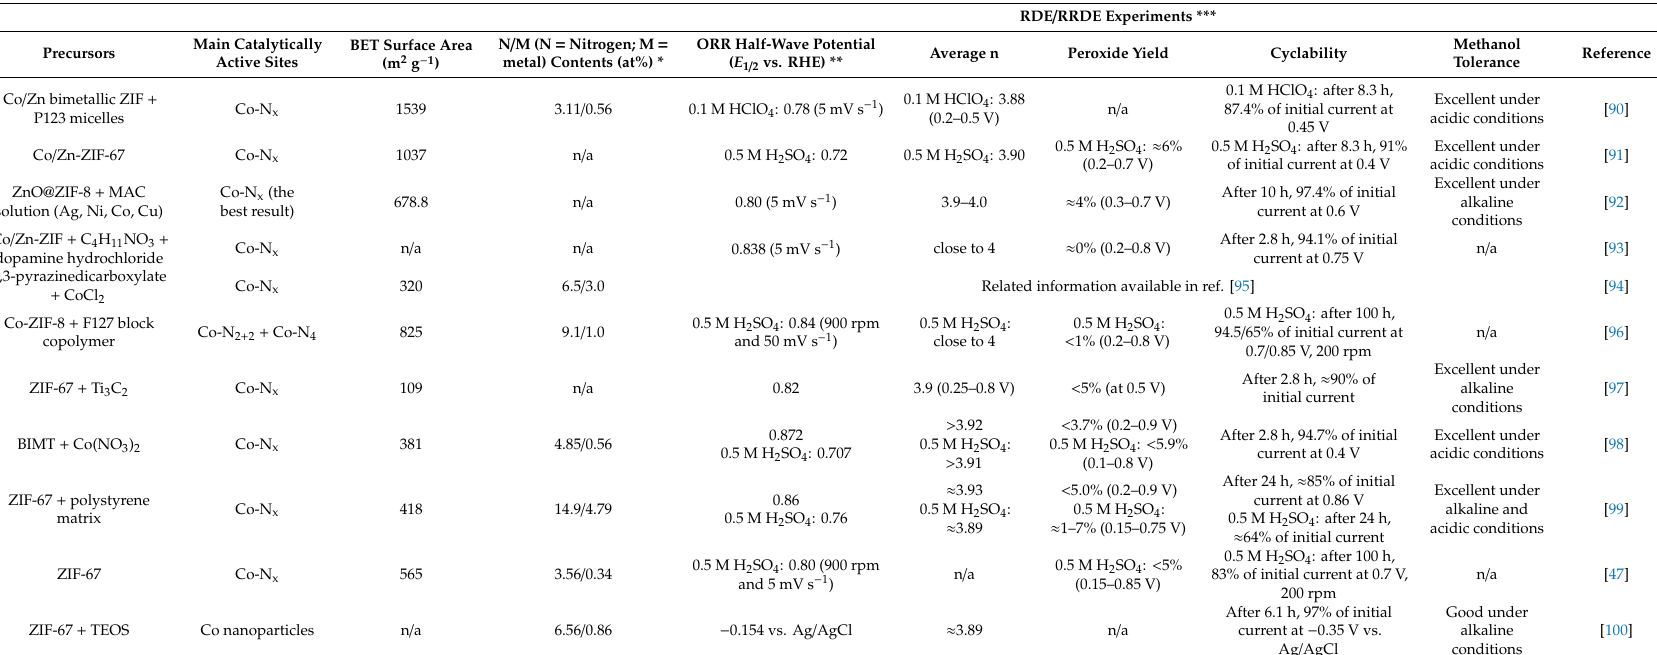
* Sometimes, weight percentage was used, and hence, “wt %” data are provided. More than one metal or heteroatom can be provided depending on the active sites involved. ** Potentials are referenced to RHE except when stated otherwise. The ORR performance values were evaluated at 1600 rpm and 10 mV s − 1 except when stated otherwise. *** All the ORR performance values listed were measured in 0.1 M KOH except when stated